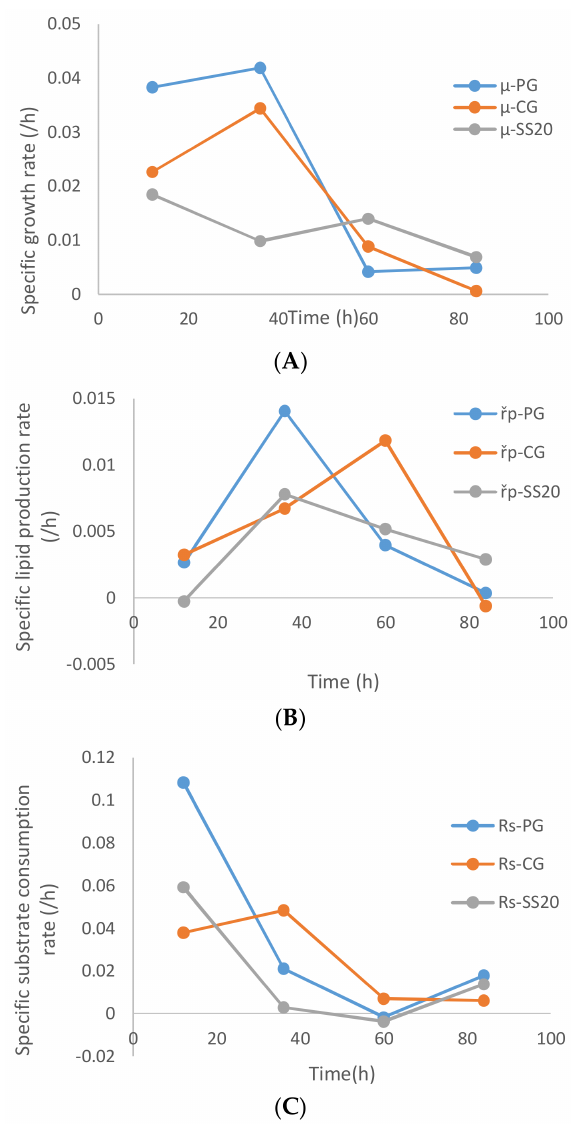
Figure 8. ( A ) Specific growth rate, ( B ) specific lipid production rate, and ( C ) specific glycerol consumption rate comparison between fermentations performed with sludge (SS20, 20 g/L), crude glycerol (CG), and pure glycerol